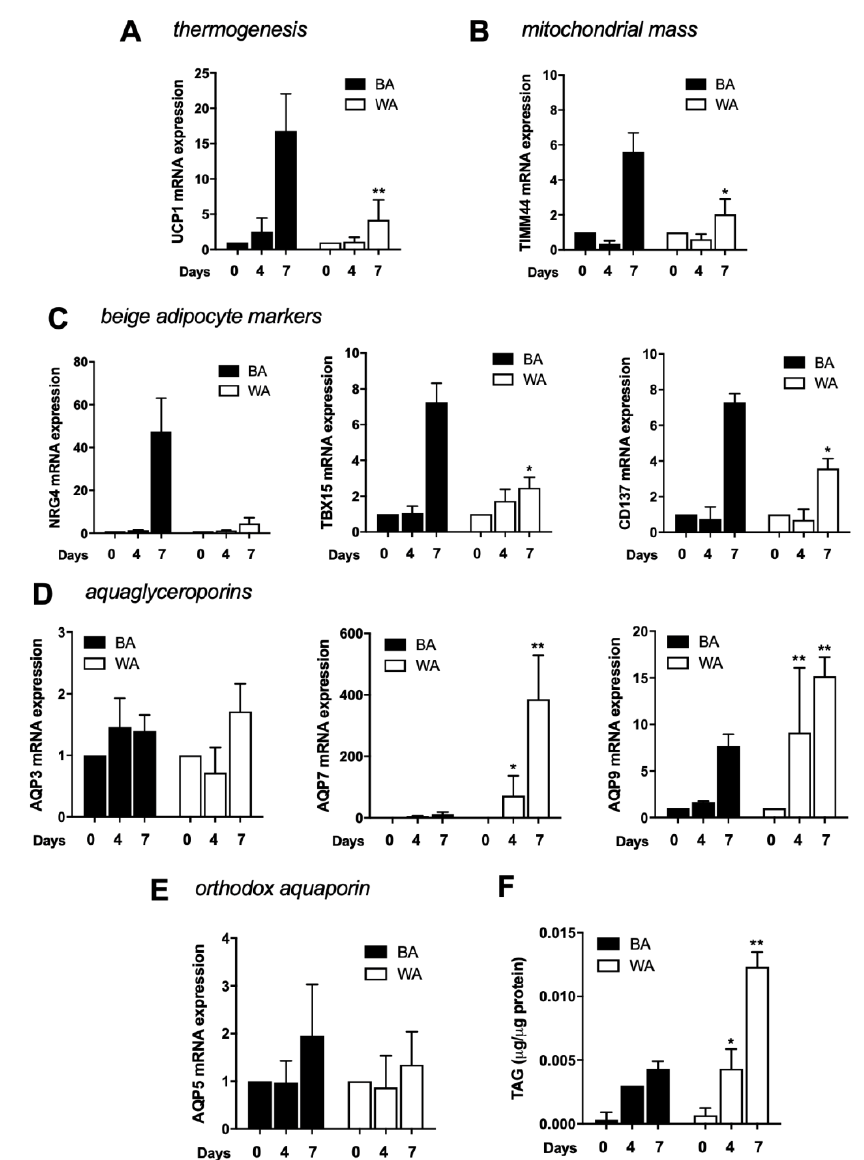
Figure 3. Beige phenotype achievement along di ff erentiation. ( A ) Relative expression of UCP1, ( B ) TIMM44, ( C ) NRG4, TBX15, CD137, ( D ) AQP3, AQP7, and AQP9 and ( E ) AQP5, in 3T3-L1 fibroblasts induced to di ff erentiate into beige (BA; black bars) and white (WA; white bars) adipocytes at day 0, 4, and 7 of differentiation. Gene expression values are relative to ARP and Eef2 and to day 0. ( F ) Triacylglycerols accumulation in 3T3-L1 fibroblasts induced to differentiate into beige (BA; black bars) and white (WA; white bars) adipocytes at day 0, 4, and 7 of differentiation. Data represent mean ± SEM of three independent experiments. * p < 0.05, ** p < 0.01, differentiation time point vs. previous time point.